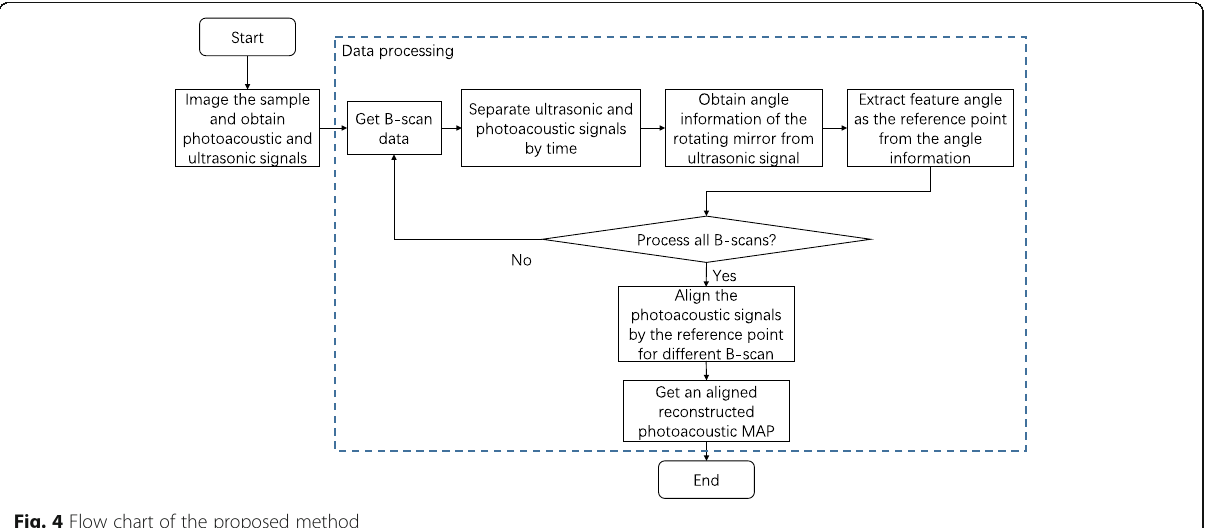
Fig. 4 Flow chart of the proposed